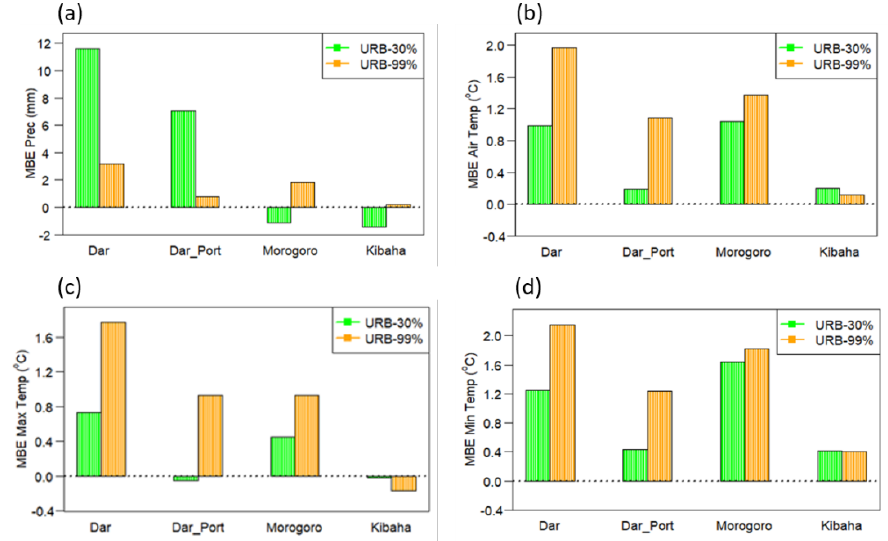
Figure 11. Overall stations mean bias for ( a ) daily precipitation, ( b ) near-surface temperature, ( c ) maximum temperature, and ( d ) minimum temperature at future low and high scenario (URB-30% and URB-99%).